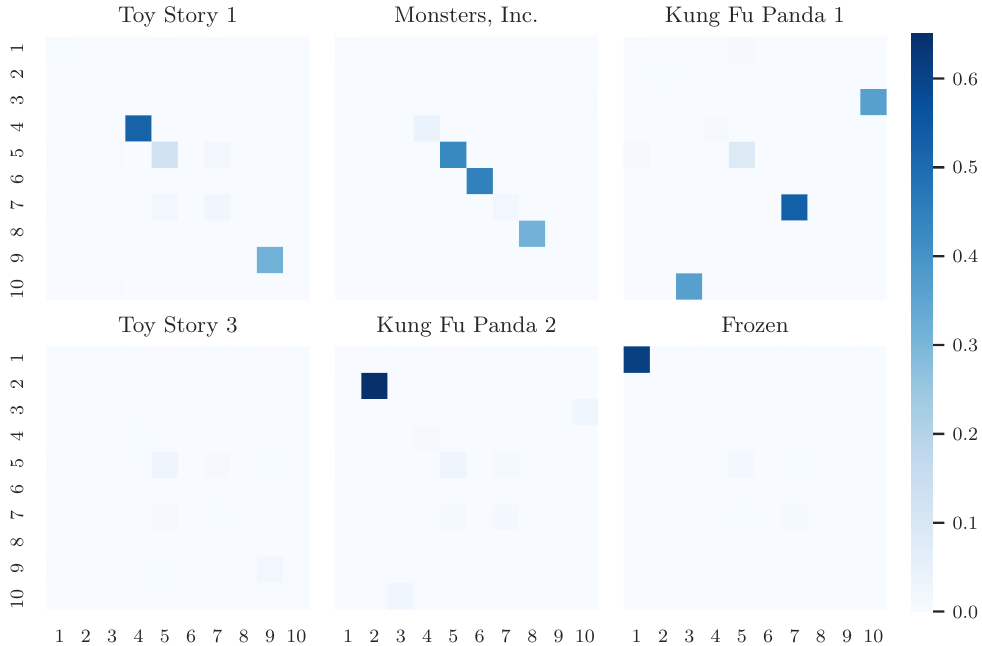
Figure 8. Colored heatmap of affinity tensor R , trained on the Amazon review data represented as input tensor using multiplicative update rules. Table 11. Top 10 representative words per dimension of the basis matrix A , trained on the Amazon review data as input tensor using multiplicative update rules.